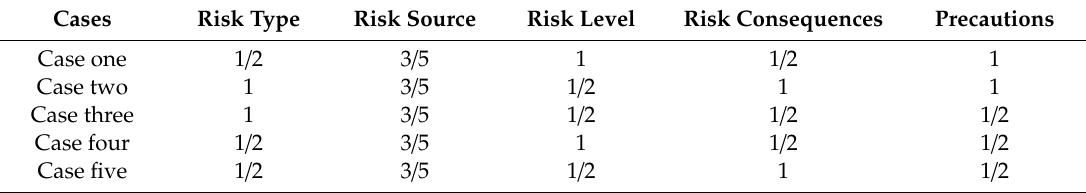
Table 9. Content-based semantic similarity calculation results.